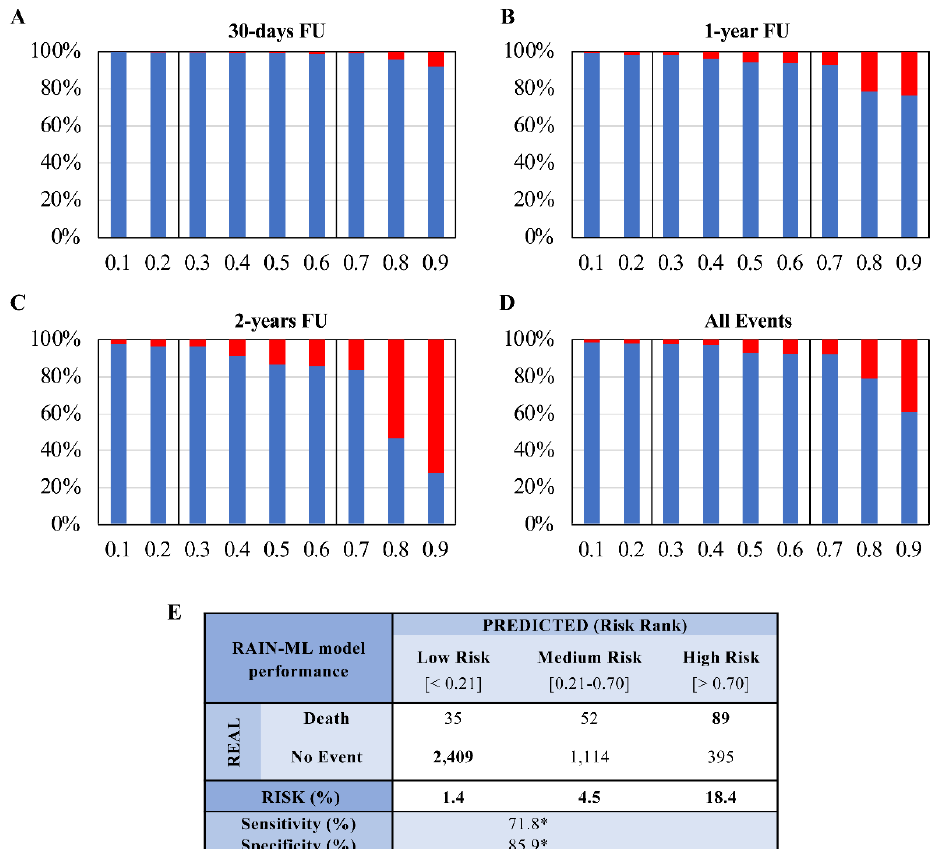
Figure 3. Stratification of all-cause mortality risk according to the RAIN-ML model . Patient distri- bution and risk stratification analysis in the mixed discovery and external validation cohort (n = 4094). ( A – D ) Histograms showing the proportion of patients ( y -axis, %) stratified according to their outcome (No Event, grey vs. Death, black); on the x -axis are reported the ML coefficients (for the RAIN-ML prediction model). Patients were stratified considering death occurrence at different follow-ups (30 days, 1 year, 2 years, and all events). ( E ) The table shows confusion matrix reporting risk strat- ification analysis, sensitivity, and specificity, for the RAIN-ML prediction model * Sensitivity and specificity were derived on a mixed cohort composed of the low- and high-risk groups, after exclusion of patients at intermediate